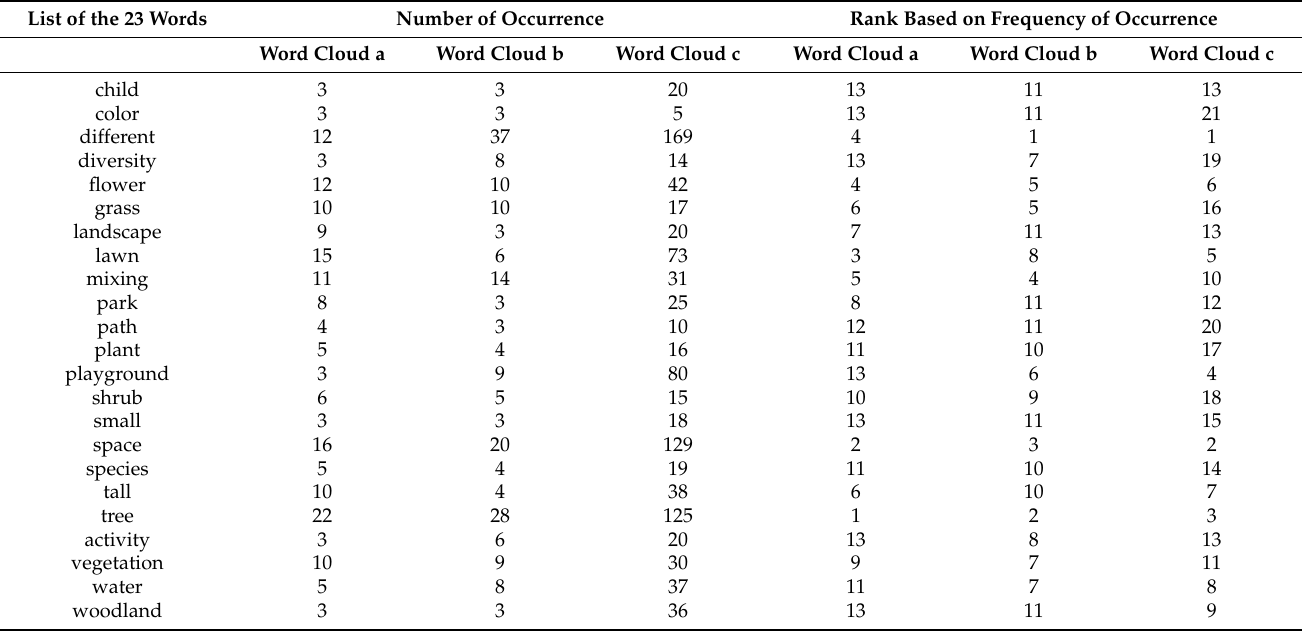
Table 1. List of the 23 words common across the three word-clouds (in alphabetical order) with their rank based on their occurrences. Word-clouds a, b and c refer to Figure